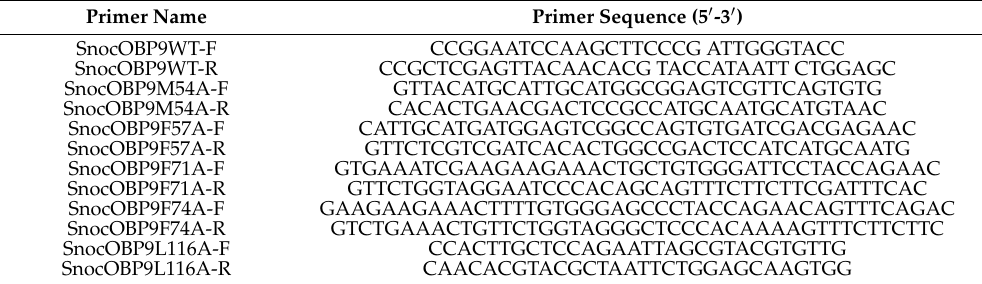
Table 7. Primers for protein